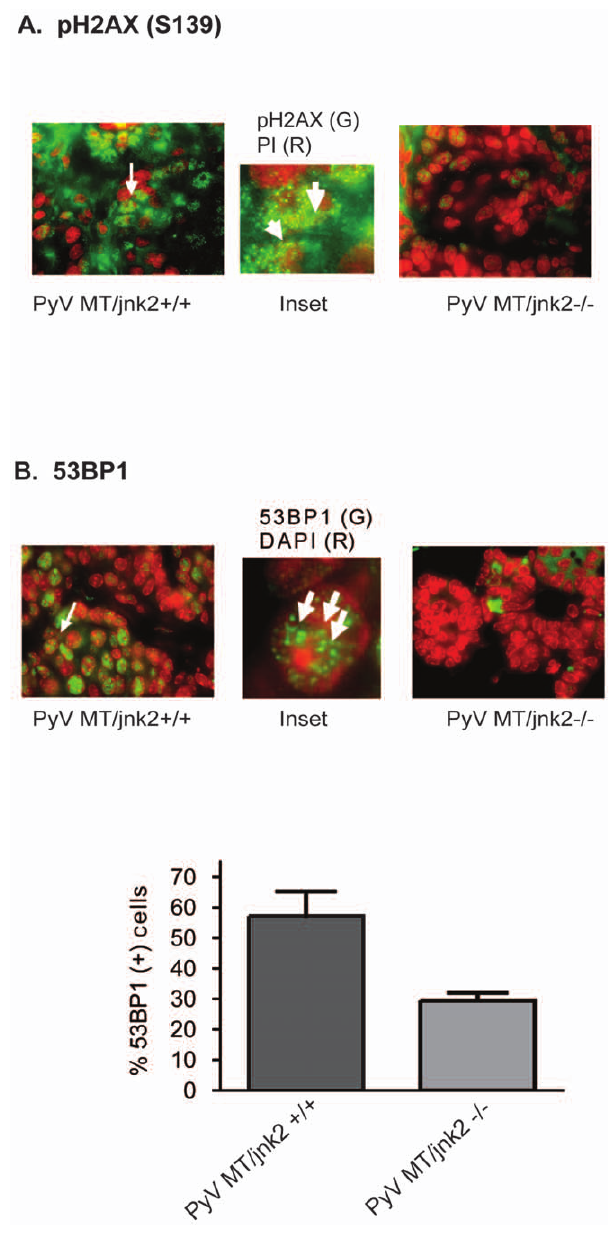
Figure 3. pH2AX and 53BP1 staining in PyV MT tumors. A ). Paraffin embedded PyV MT tumors were stained with pH2AX antibody (green). Nuclei were counter stained with propidium iodide (PI, red); Inset shows high magnification of a cell from a PyV MT/ jnk2 + / + tumor with arrows pointing at foci. B ). Tumor sections were processed as in A) except incubated with 53BP1 primary antibody. Images were captured and pseudo-colored. 53BP1 antibody (red) and DAPI nuclear stain (green). Inset shows high magnification of a cell from the PyV MT/ jnk2 + / + with arrows pointing at foci. C ). Cells with $ 4 nuclear 53BP1 foci were counted as positive cells in each field; a minimum of 5 fields were counted/mouse. Each point represents a tumor average